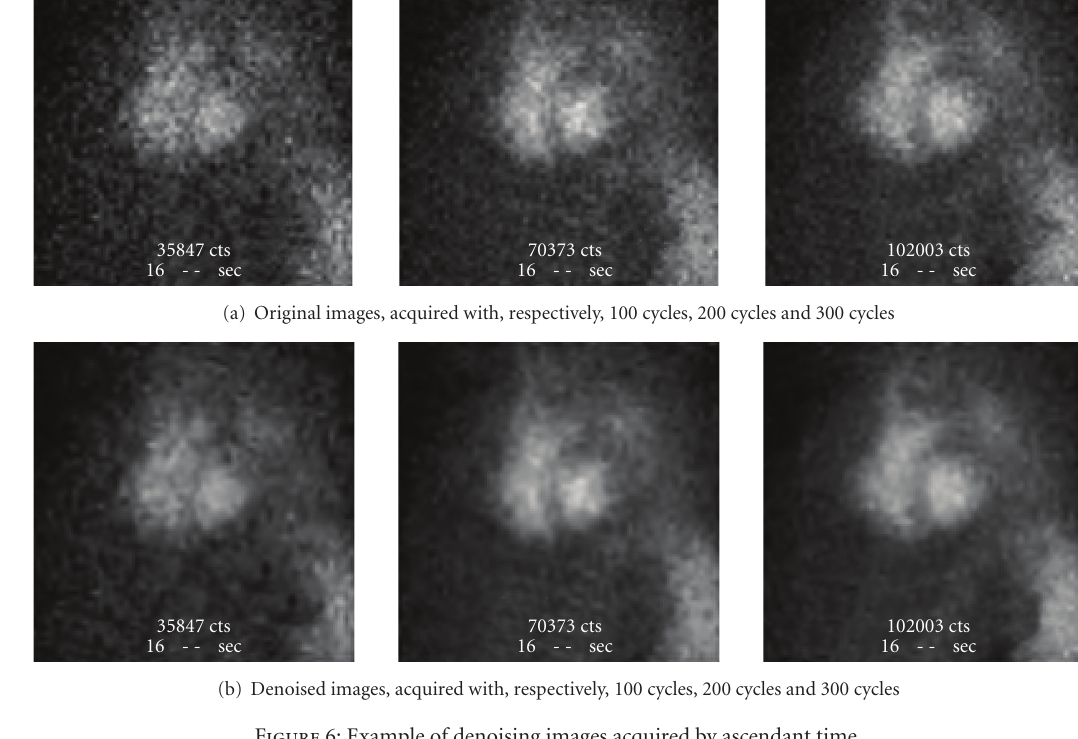
Figure 6: Example of denoising images acquired by ascendant time. Table 2: Statistics on the value of β (for 80 scintigraphic